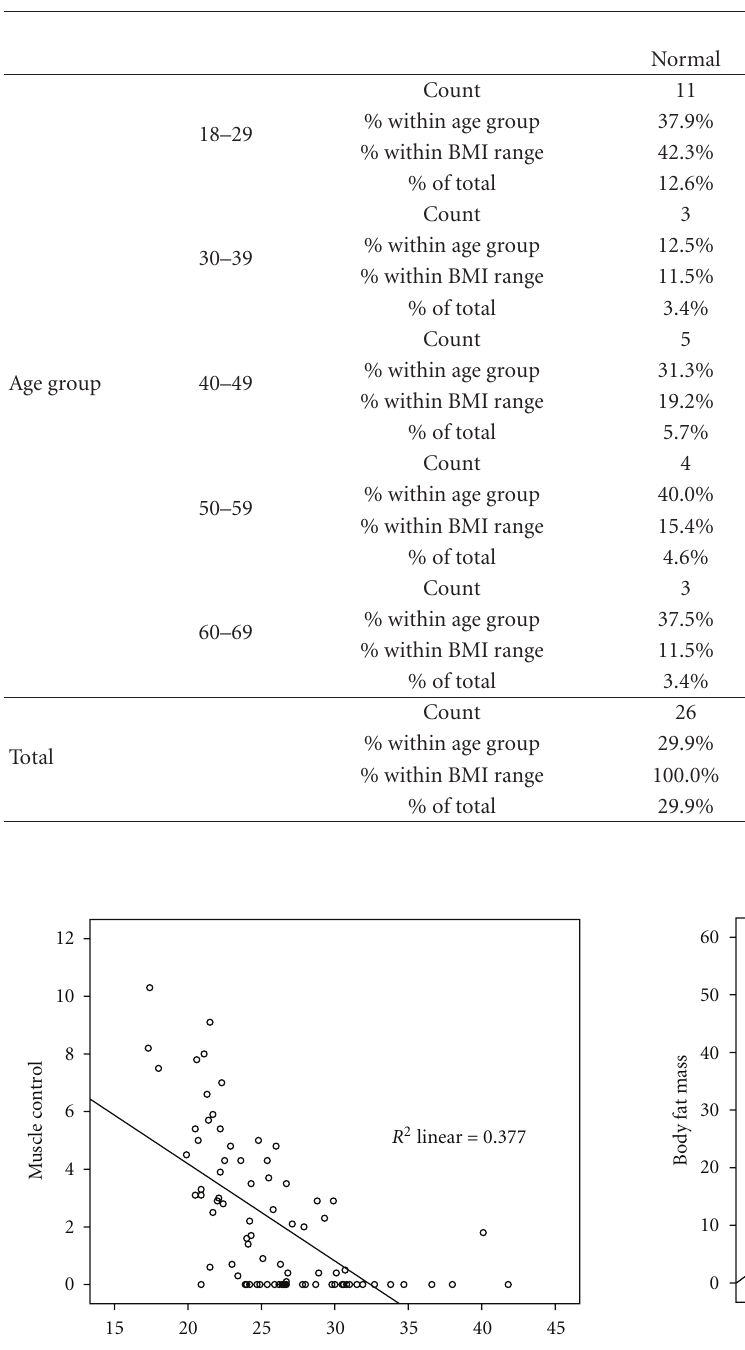
Table 3: Age group ∗ BMI range cross tabulation.